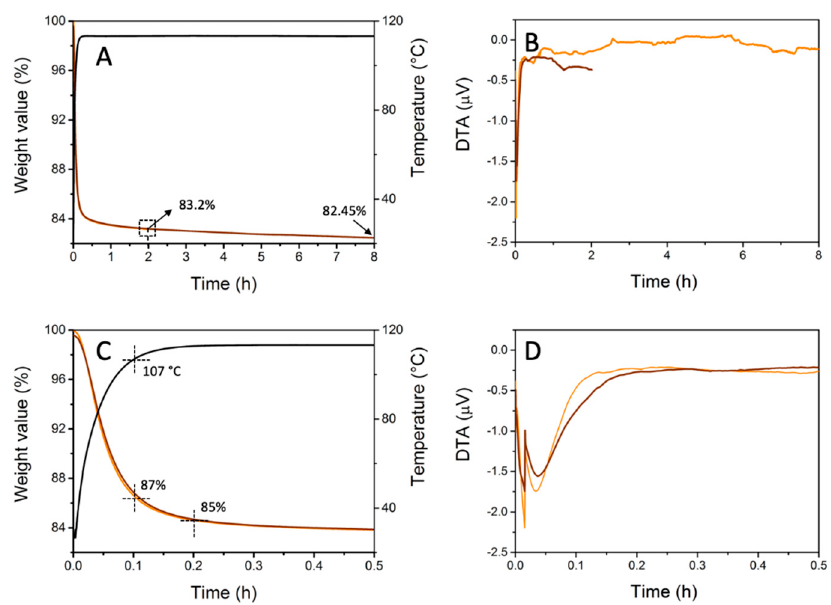
Figure 6. TGA (panel ( A , C )) and DTA (panel ( B , D )) curves registered versus temperature up to 110 °C (black line) and time 2 h (orange line), 8 h (brown line) registered for the sample TiO 2 _0 h treated under air flow.